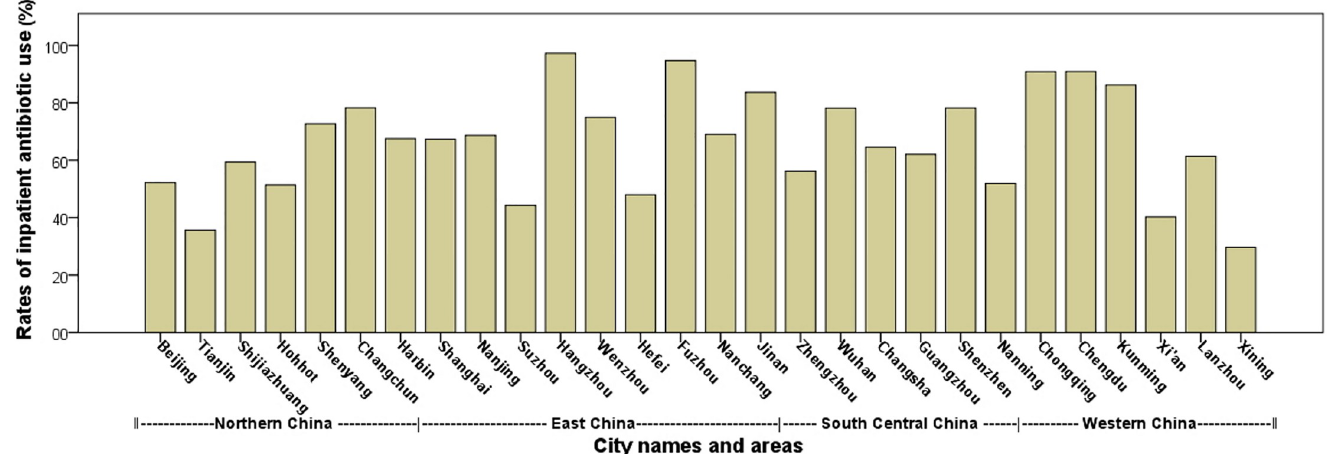
Fig 2. The rates of inpatient antibiotic use for newborns among cities. The bars illustrated the mean rates of inpatient antibiotic use among the participating hospitals from cities and areas in 2008–2010. Northern China included geographical regions of North China and Northeast China, and Western China included Southwest China and Northwest China.